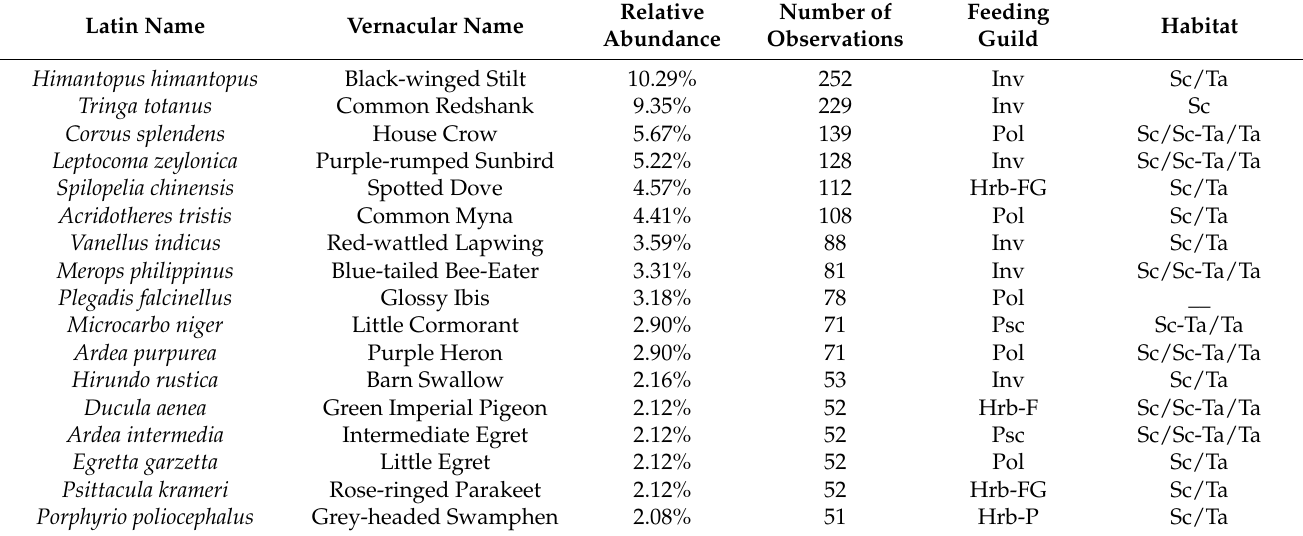
Table 1. List of bird species, in order of relative abundances, observed during point-count sur- veys performed in Kalametiya Lagoon, Sri Lanka. This table only includes observations made during the surveys. Feeding Guild labels: (i) Inv = Invertebrate feeder, (ii) Pol =